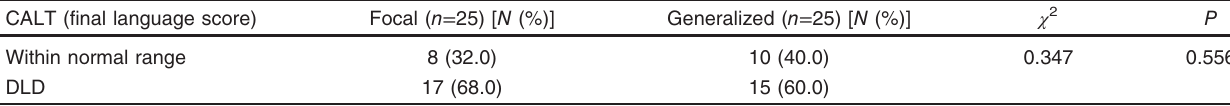
Table 5 Comparison between the studied groups according to the Comprehensive Arabic Language Test results CALT (final language